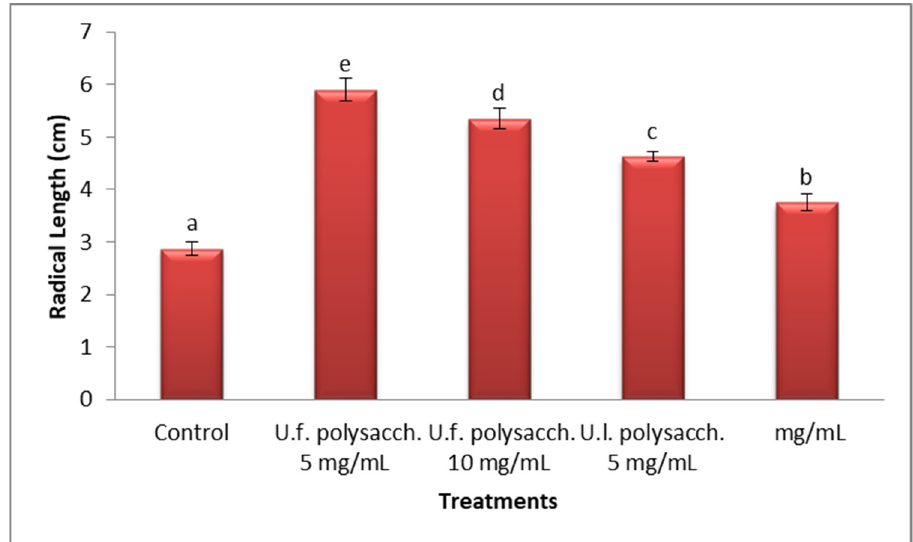
Figure 3. ( a ) Zea mays growing seedlings (U.f 50%: U.f. polysacch.5mg/mL, U.f 100%: U.f. polysacch. 10 mg/mL), ( b ) Zea mays growing seedlings (U.l 50%: U.l. polysacch. 5 mg/mL, U.l 100%: U.l. poly- sacch. 10 mg/mL).